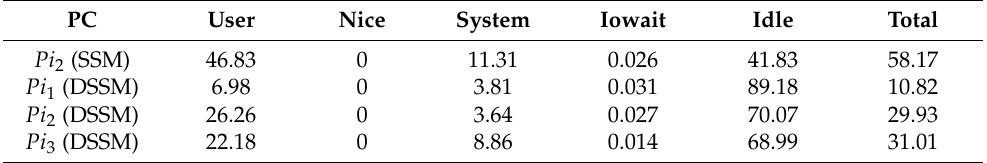
Table 10. Details of CPU usage in Ex 3.